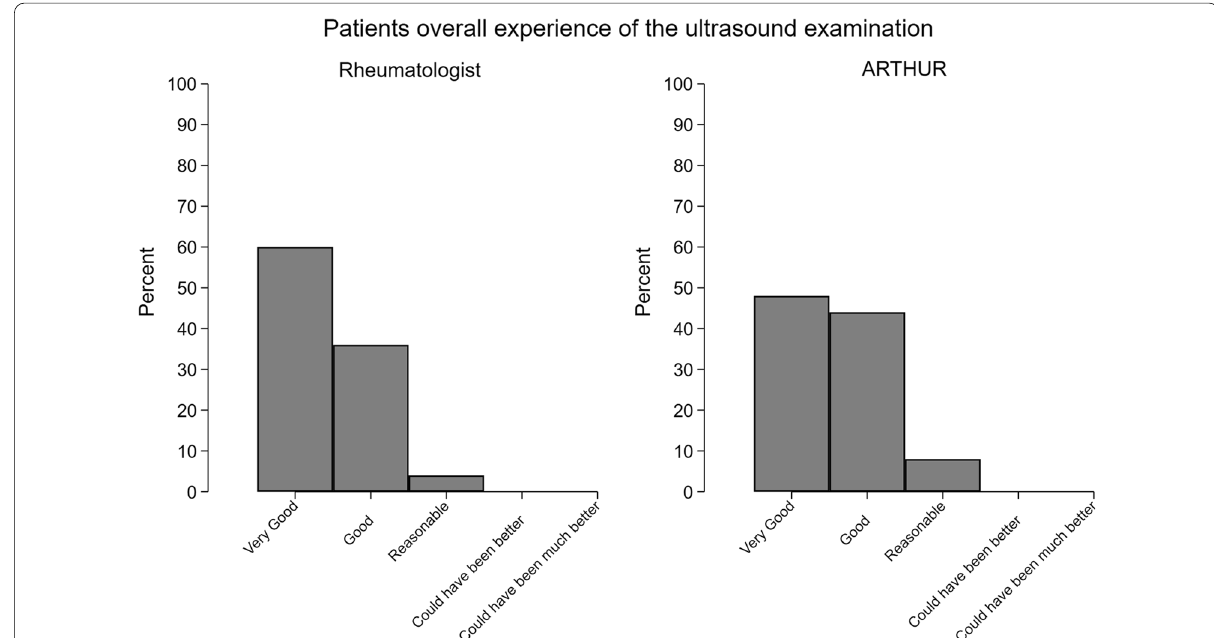
Fig. 3 Overall experience with ultrasound scanning by Rheumatologist and